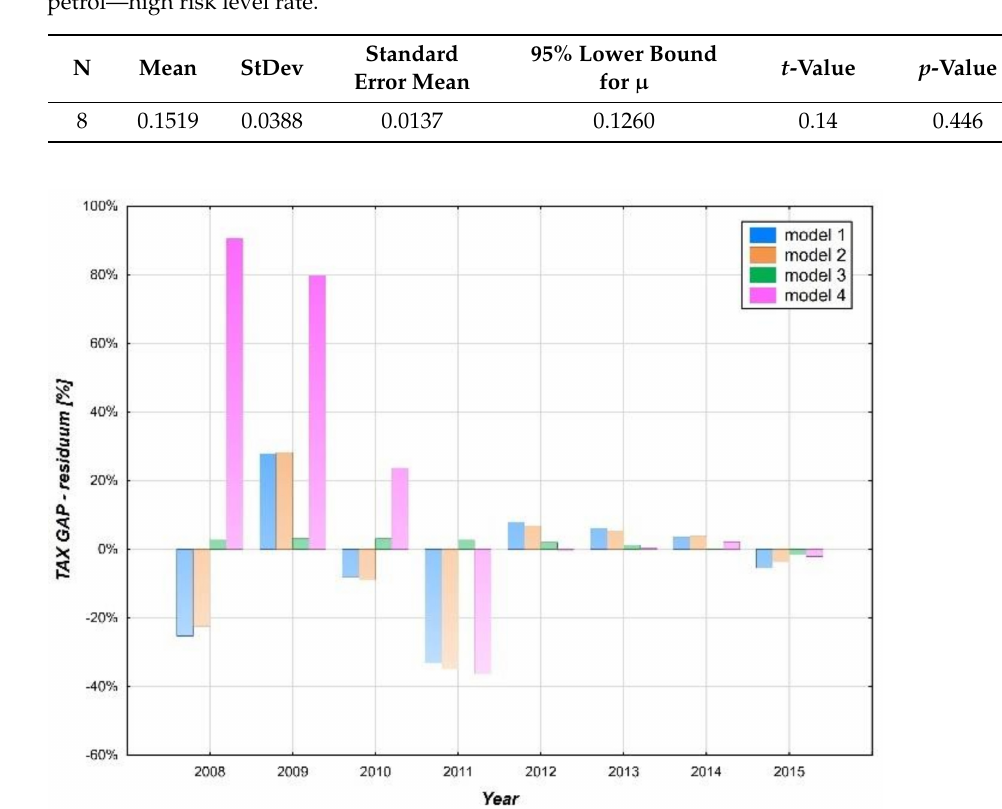
Table 3. The tax gap in % of the overall consumption and in EUR million classified into diesel and petrol—high risk level rate.